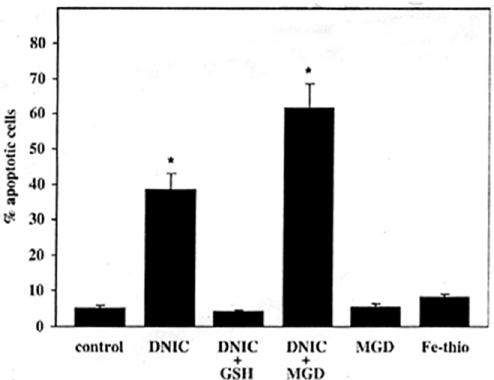
Figure 23. Increase in the number of pro-apoptotic Jurkat cells in case of the combined effect of M- DNIC-thiosulphate (100 μ mol) + MGD (200 μ mol) on them (the forth column). The apoptotic effect of DNIC (100 μ mol) alone, DNIC (100 μ mol) + GSH (2 mmol), MGD (200 μ mol) alone and Fe 2+ + thiosulphate(100 μ mol) for 24 h is also shown [106].